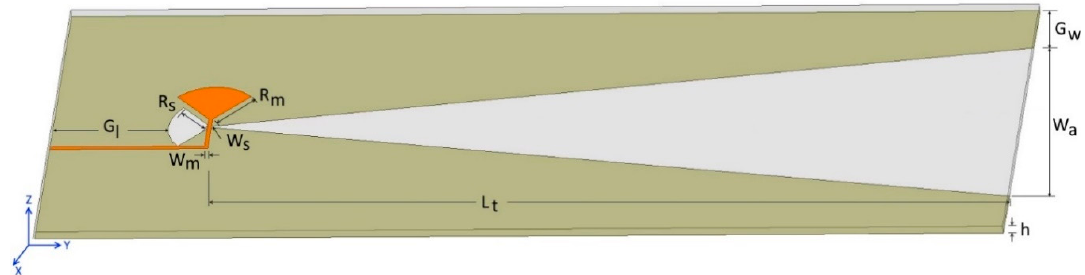
Figure 1. Parameters for a tapered slot antenna (TSA) on a double-sided printed circuit board (PCB) with a microstrip (orange color) on the top side and ground plane (olive color) on the bottom side.